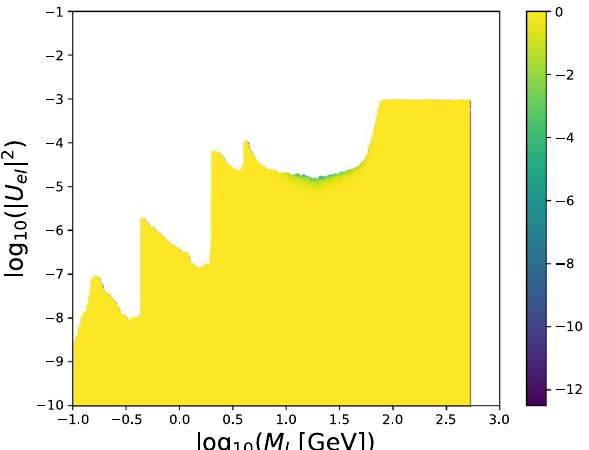
Fig. 22 Partial likelihood from prompt searches with DELPHI, in the M